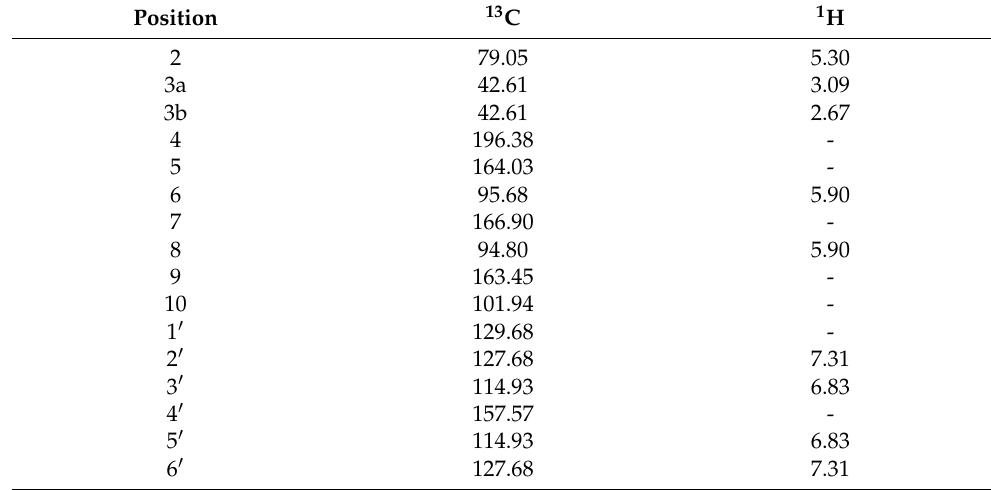
Table 1. 13 C and 1 H NMR chemical shift values (ppm) of naringenin.